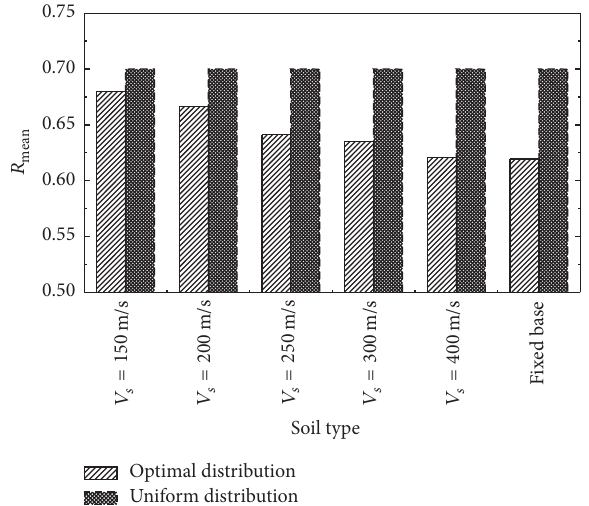
Figure 17: The comparison of 𝑅 mean between optimal distribution and uniform distribution of VEDs (10-story structure).